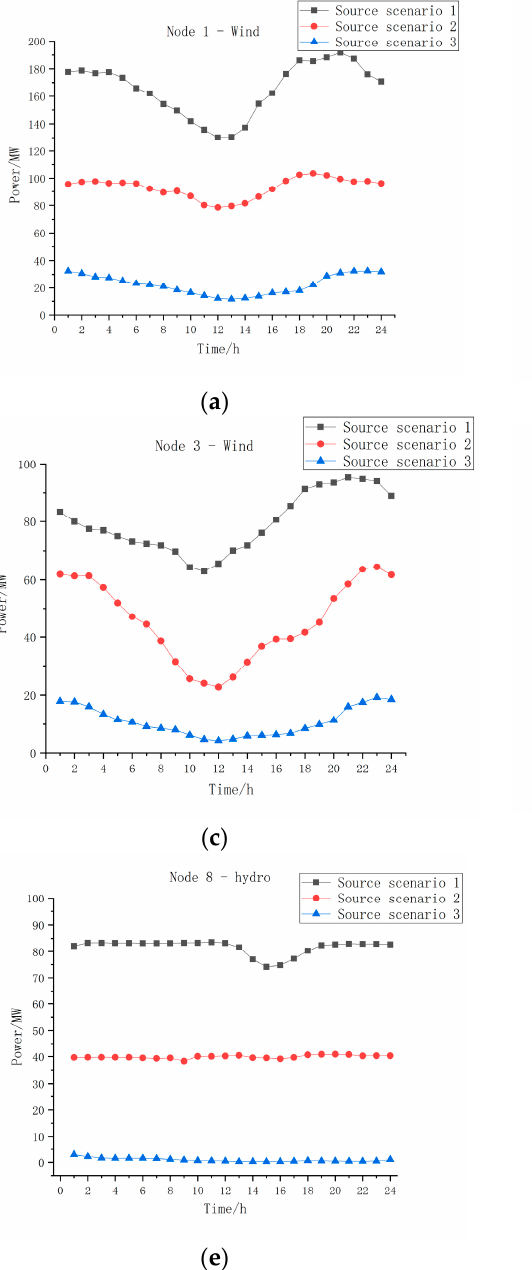
Figure 8. Output curve of each source. ( a ) Node 1-wind. ( b ) Node 2-wind. ( c ) Node 3-wind. ( d ) Node 6-PV. ( e ) Node 8-hydro.